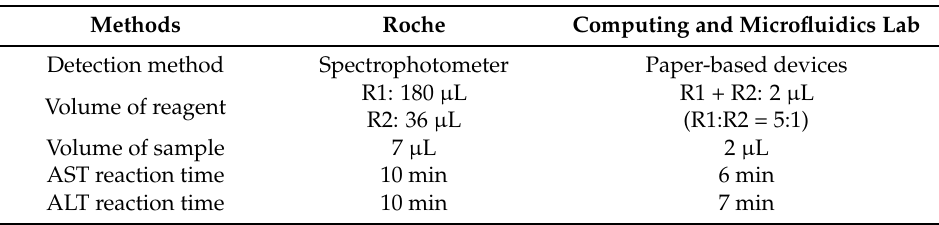
Figure S1: Adobe Photoshop 7.0 software analyzed RGB values as color intensity. Figure S2: (a) Change in mean R + G + B values color intensity over time for AST; (b) Use the value 200 to subtract the detection values from (a) to reverse the results. Figure S3: (a) The result of AST detection obtained by printer method; (b) The result